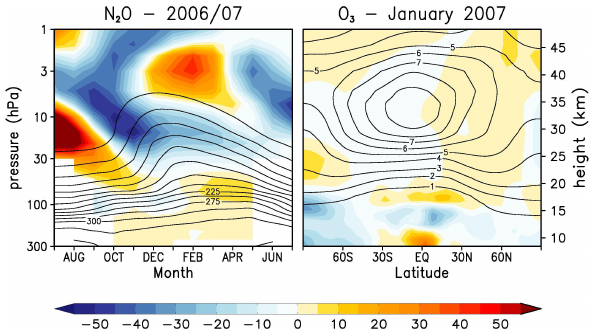
Figure 11: Time-pressure cross section of climatological MIPAS N 2 O (ppbv, isolines, left) and N 2 O differences between 2006/7 and the climatology (ppbv, shaded, left), both averaged over all latitudes south of 70°S. Latitude-pressure cross section of climatological January MIPAS ozone (ppmv, isolines, right) and ozone differences between January 2007 and the climatology (ppbv, shaded, right). Positive differences are shown in warm colours and negative in cold colours.